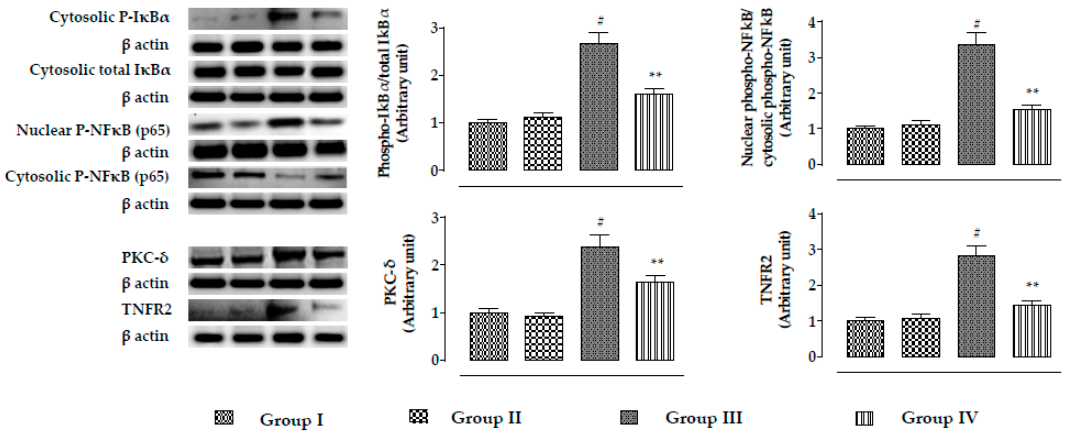
Figure 5. The effects on NF- κ B, PKC- δ , and TNFR2 expressions in the absence (CdCl 2 ) and presence of RA (CdCl 2 + RA) in vitro on mouse proximal tubular epithelial cells. The relative band intensities were assessed, and the intensity of the normal control band was assigned as 1. β -Actin served as the loading control. Data are represented as means ± SD, n = 3 (number of plates). # Values significantly ( p < 0.01) differ from normal control.. ** Values significantly ( p < 0.01) differ from CdCl 2 control. Group I: untreated, Group II: RA (40 μ M), Group III: CdCl 2 (40 μ M), and Group IV: CdCl 2 (40 μ M) + RA (40 μ M).